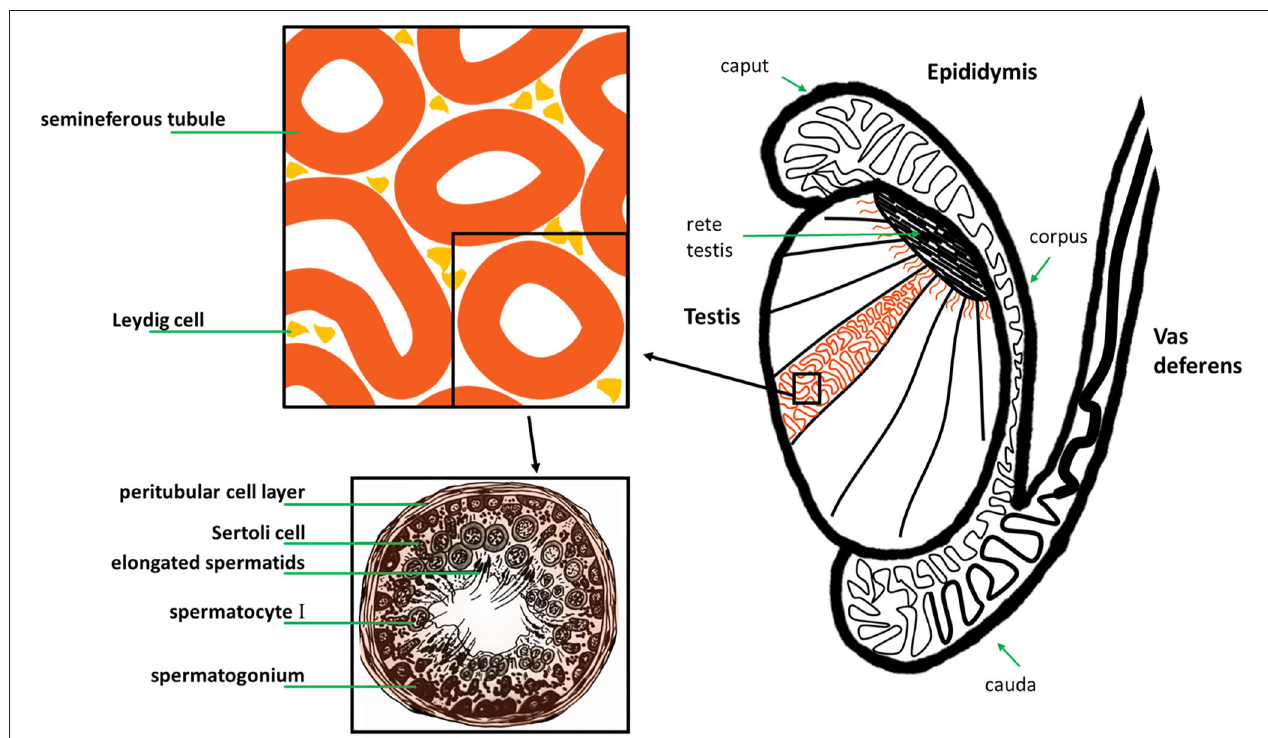
FIGURE 5 | Original: Anatomy of the human testis, epididymis and vas deferens, and histology of a human seminiferous tubule.